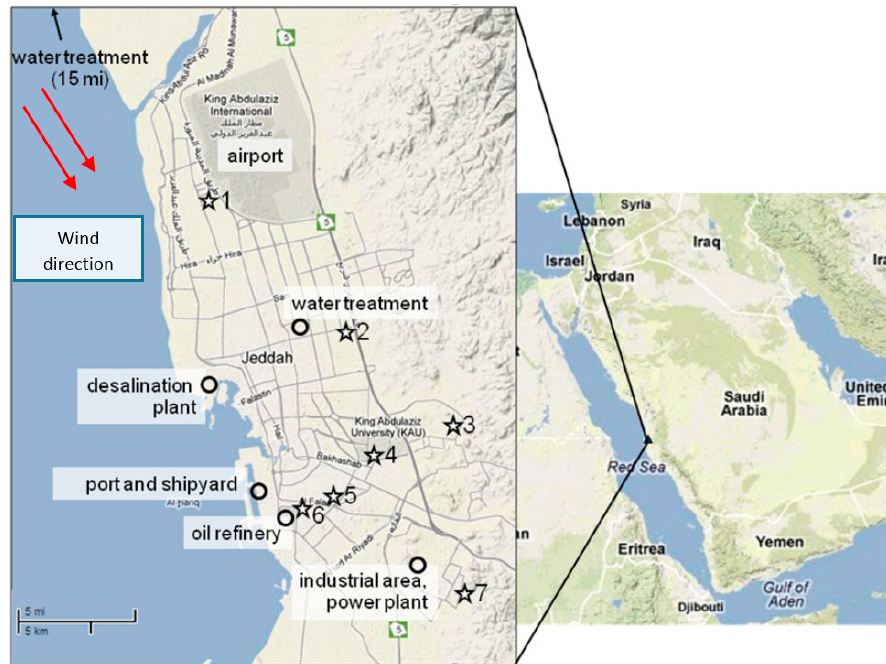
Figure 1. Locations of sampling sites (stars) and notable stationary industrial sources (circles) in Jeddah; 1 = Al ‐ Muhammadiyah; 2 = Al ‐ Rehab; 3 = Al ‐ Rughama; 4 = University Campus; 5 = Al ‐ Nuzlah Al Yamaneyyah; 6 = Pitrumin; 7 = Al ‐ Alfiyyah.